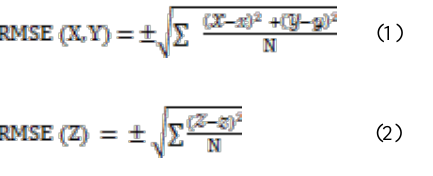
Figure 5. Orthophoto (Left) and DEM (Right) from Ebee RTK UAV